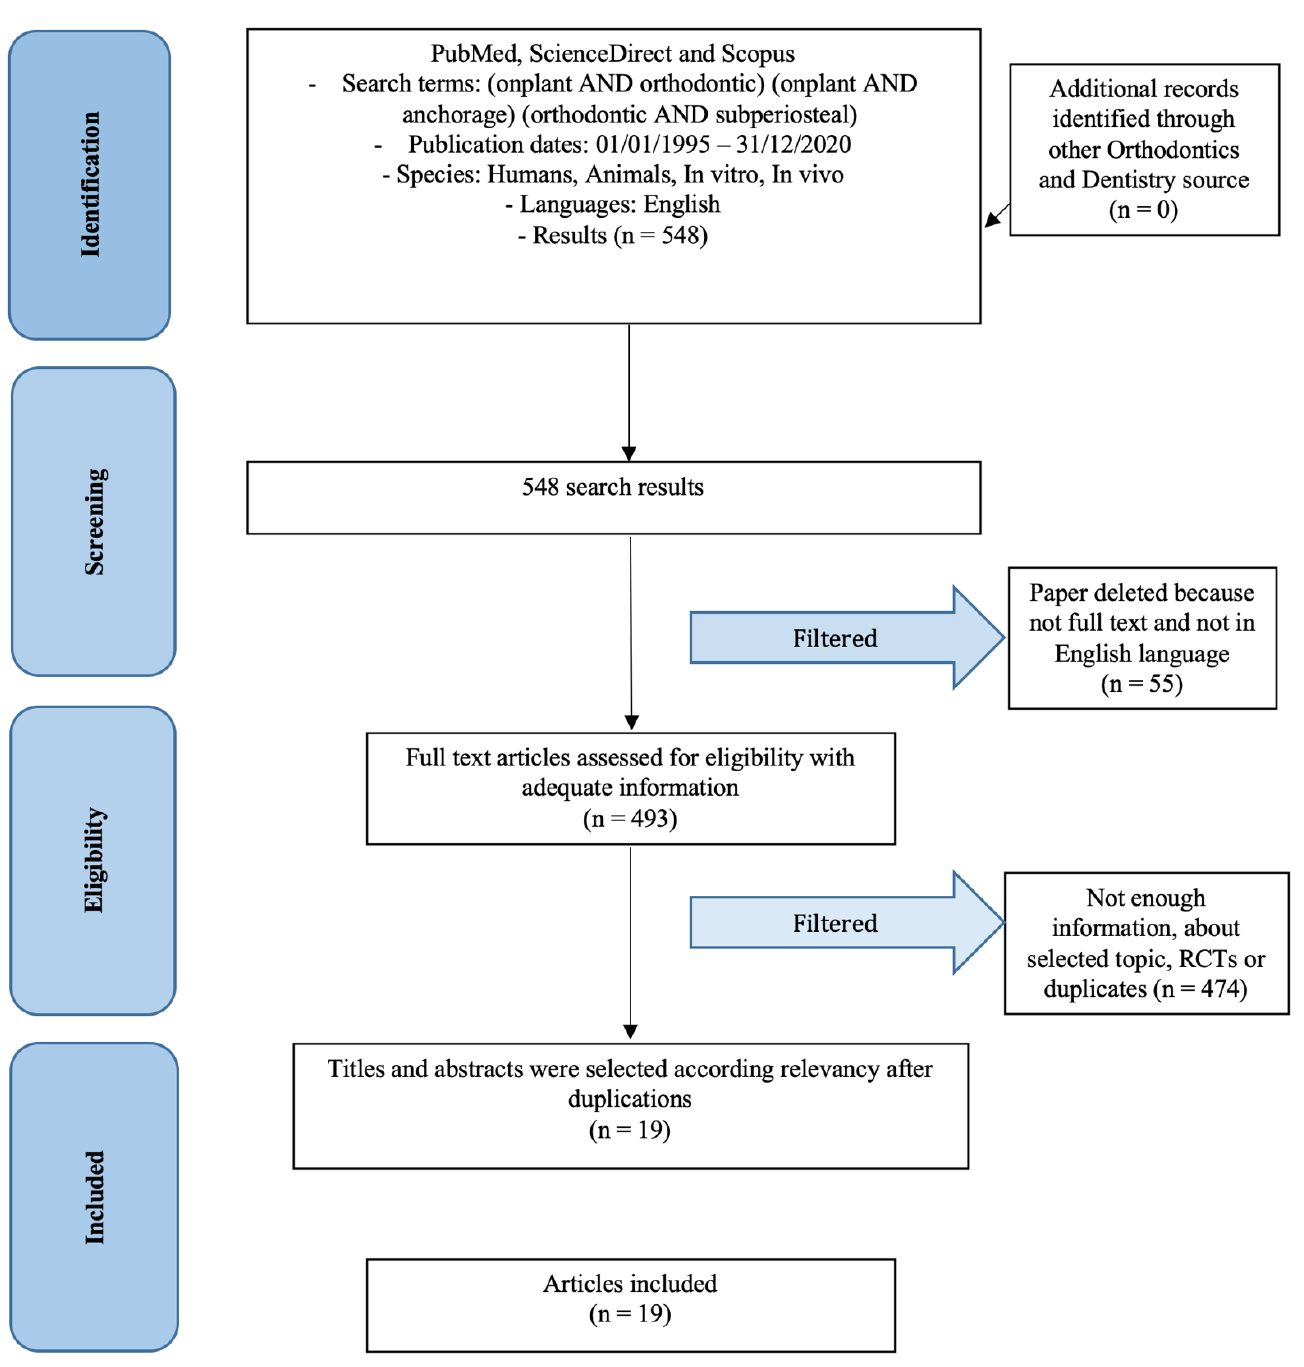
Figure 2. Flow diagram of SPIDER (tool for qualitative evidence synthesis). RCT: randomized controlled trial.